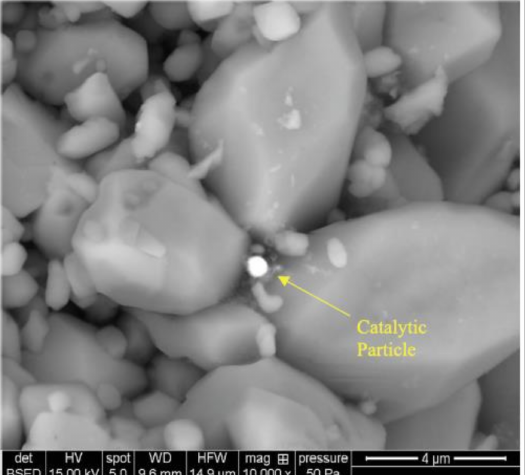
Figure 12. Scanning electron microscopy (SEM) analysis of NiMo particles inside a carbonate rock [120].